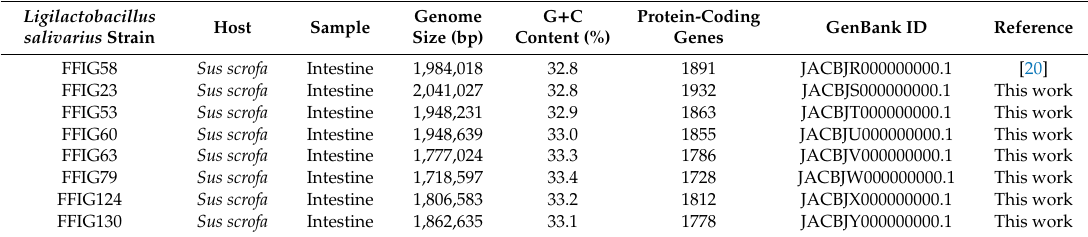
Table 1. Comparison of the general genome features of sequenced Ligilactobacillus salivarius strains isolated from the intestinal mucosa of wakame-fed pigs. L. salivarius genomes are available in the NCBI database, and the accession numbers are